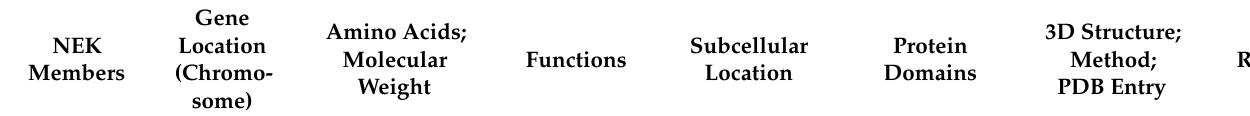
Table 1. Summary of the main molecular features of the members of the NEK